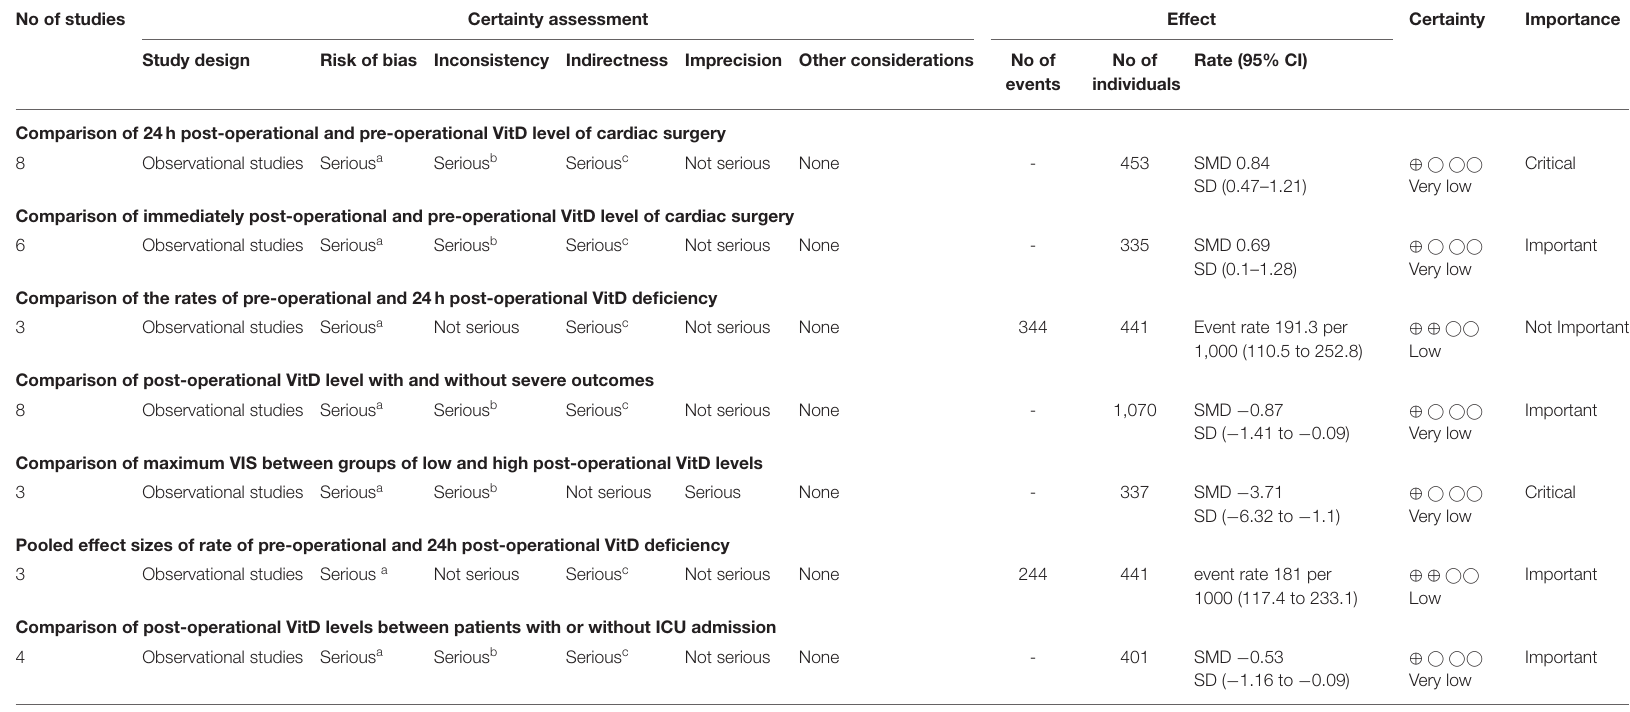
TABLE 3 | The summary of GRADE